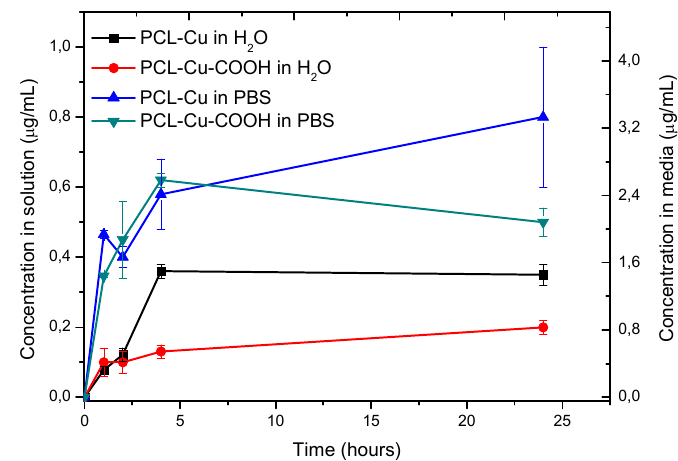
Figure 10. Cu ions release at 37 ◦ C measured by ICP-OES.